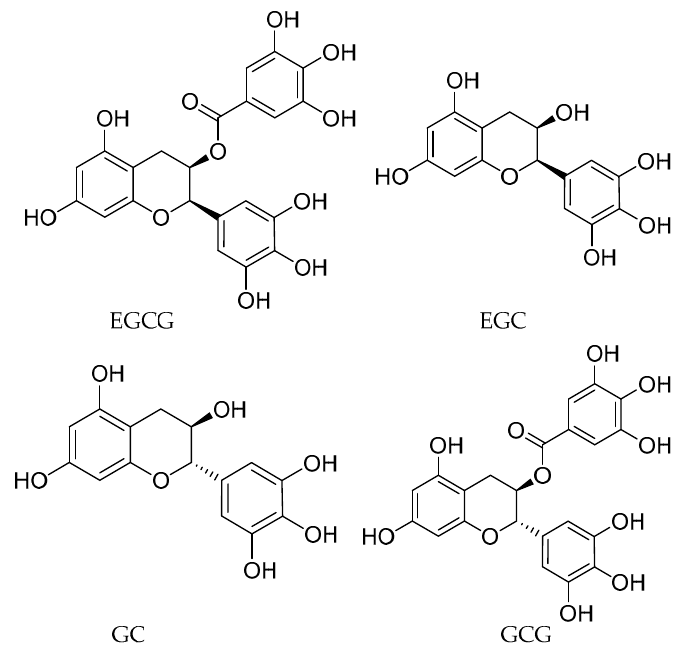
Figure 1. Structures of the green tea catechins assayed.